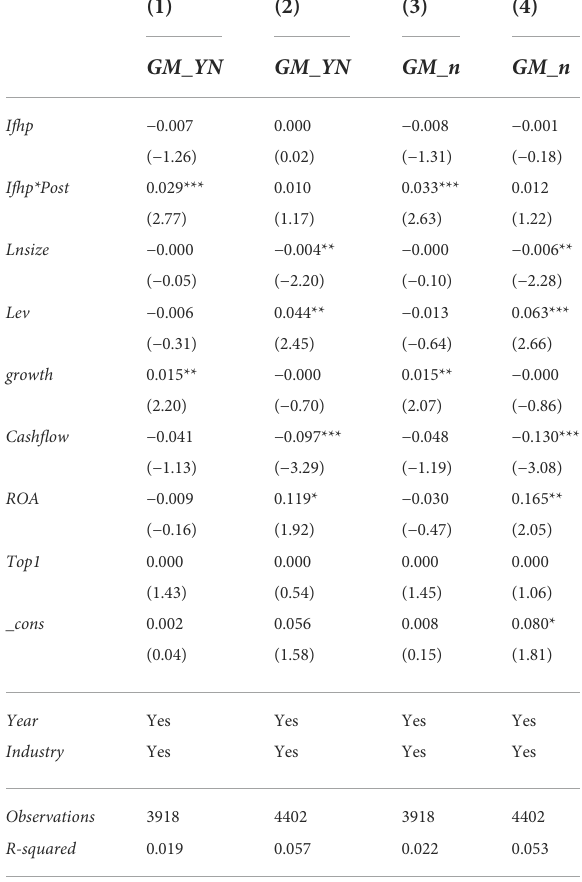
TABLE 7 Heterogeneity test for fi nancing